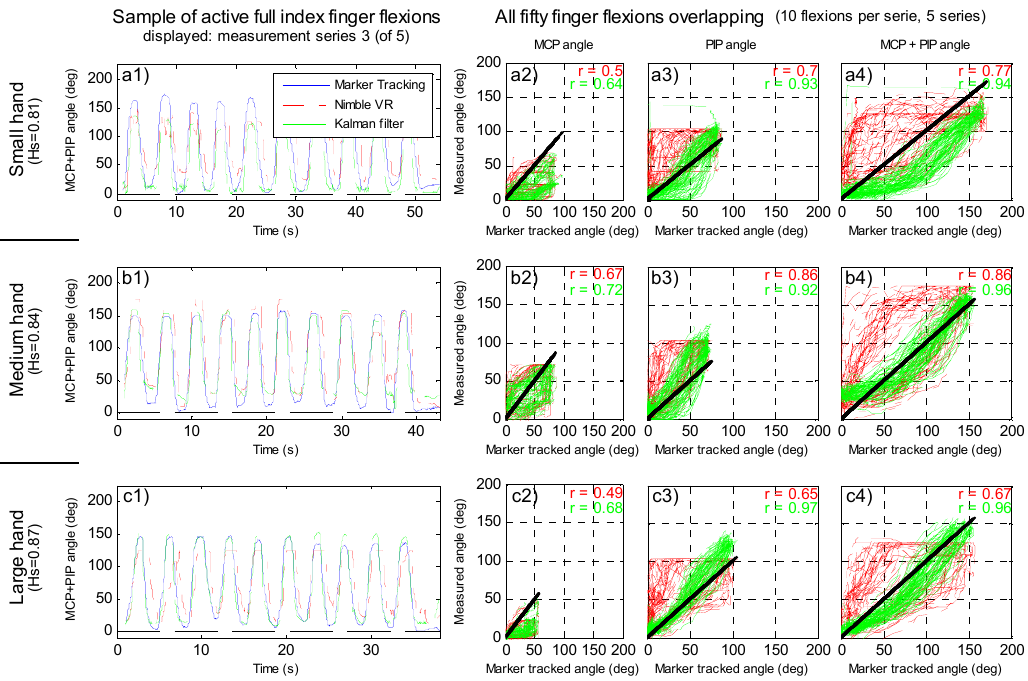
Figure 4. Finger joint estimates at dynamic finger flexions. ( a1–a4 ) small hand size; ( b1–b4 ) medium hand size; ( c1–c4 ) and large hand size. Five sessions with 10 full finger flexion repetitions each were performed. All graphs show the Nimble VR system (red dash dotted line), Kalman filter output (green dashed line), and Marker Tracking measurements (blue continuous line). Left three graphs show the combined metacarpophalangeal (MCP) and proximal interphalangeal (PIP) joint angles of the third performed measurement session. The remaining nine plots show the Nimble VR and Kalman filter output plotted vs. the Marker Tracked angles of all fifty finger flexions performed per hand. The black line presents the true angle, and the plots are given for separate and combined joints: (a2–c2) MCP; (a3–c3) PIP; (a4–c4) combined MCP plus PIP joints. In the top right, the Pearson correlation coefficient between the measured angle and marker tracked angle are given (red = Nimble VR, green = Kalman filter output).